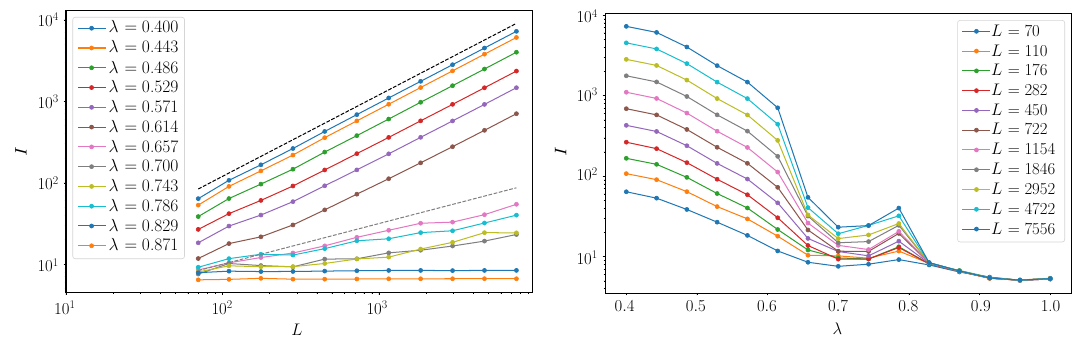
FIG. 8. Inverse participation ratio ( I ) averaged over all eigenstates of the orthogonal matrix O that governs the dynamics of Majorana fermions up to the total system size L = 7556. In the left panel, the black and gray dashed lines serve as references for the scaling laws √ L , respectively. I ∼ L and I ∼